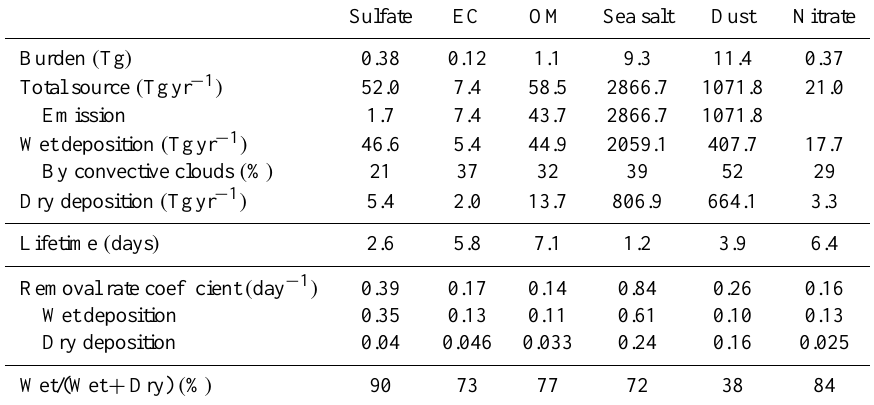
Table 5. Global aerosol budgets in ModelE2-OMA. Note that the sulfate and nitrate budgets are presented as TgS and TgN,